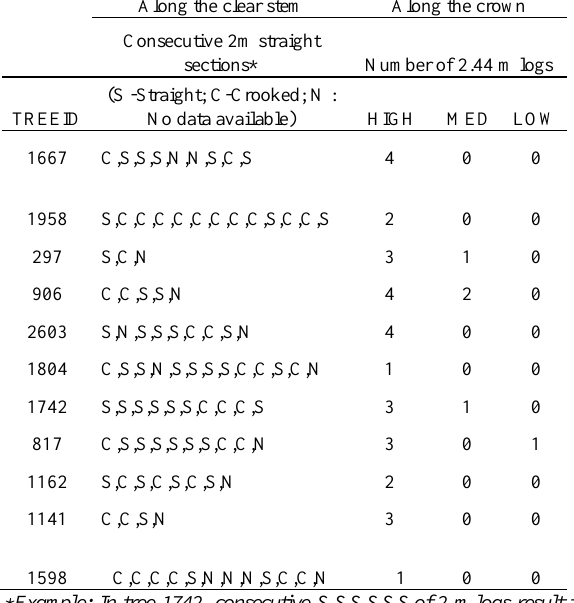
Table 3. Estimation of log quality determinants of a few sampled